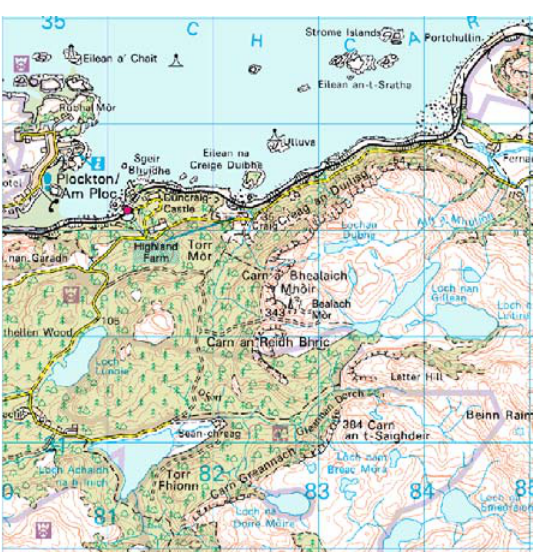
Figure 1b. Topographic map of Plockton – an area of coastal (some intertidal) islands, inland lakes, steep rocky slopes, forested and un-forested